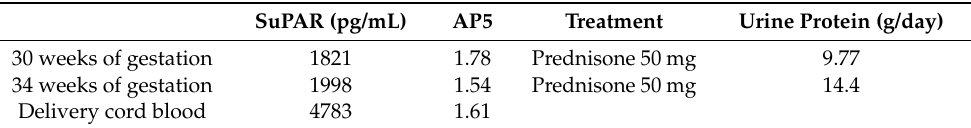
Figure 3. Ultrasound images of baby’s left and right kidney at 6 weeks of age. Table 1. Soluble urokinase-type plasminogen activator receptor (SuPAR) and AP5 activity at different time points in